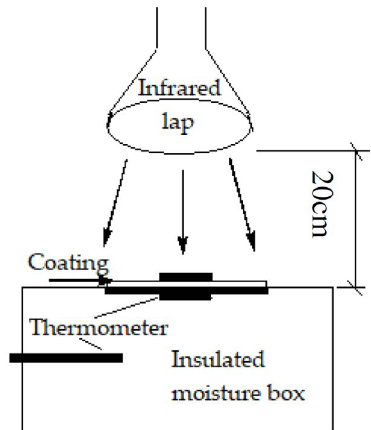
Figure 6. Schematic diagram of the self-made reflective insulation e ff ect measuring